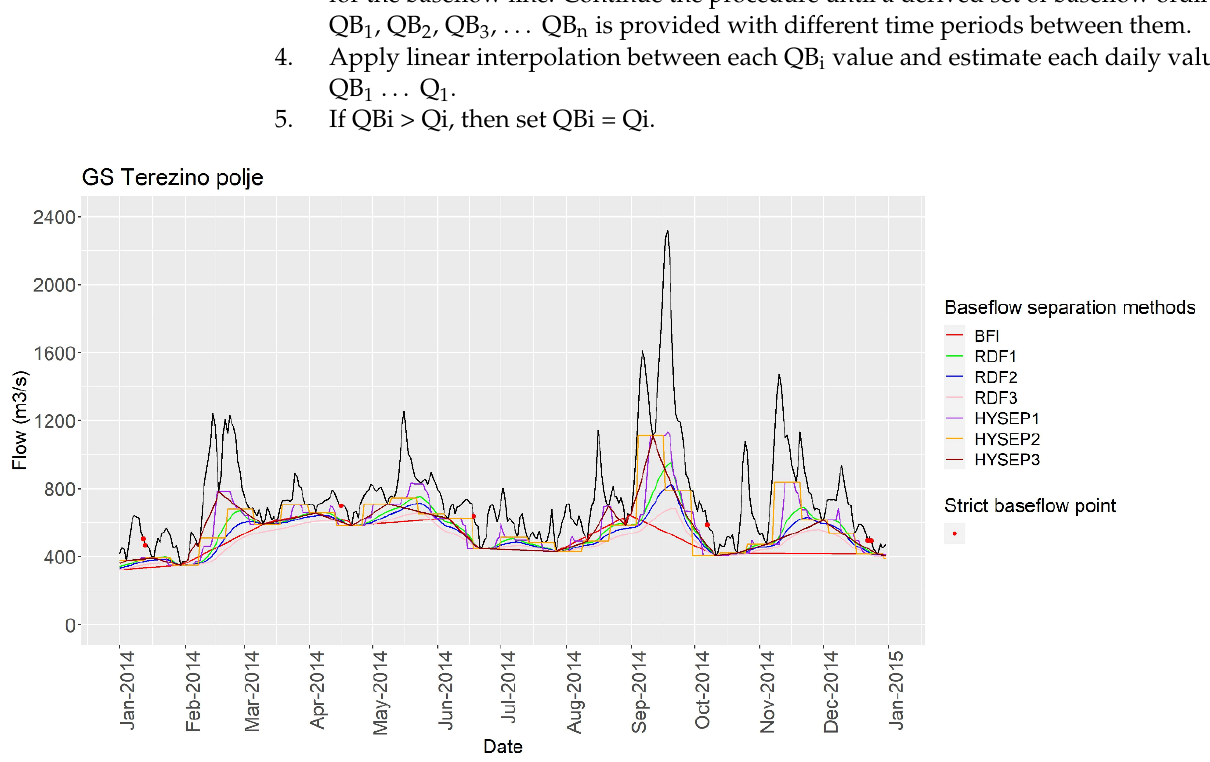
Figure 2. Example of the applied baseflow separation methods and strict baseflow points at gauging station Terezino polje on the Drava River for the year 2014.